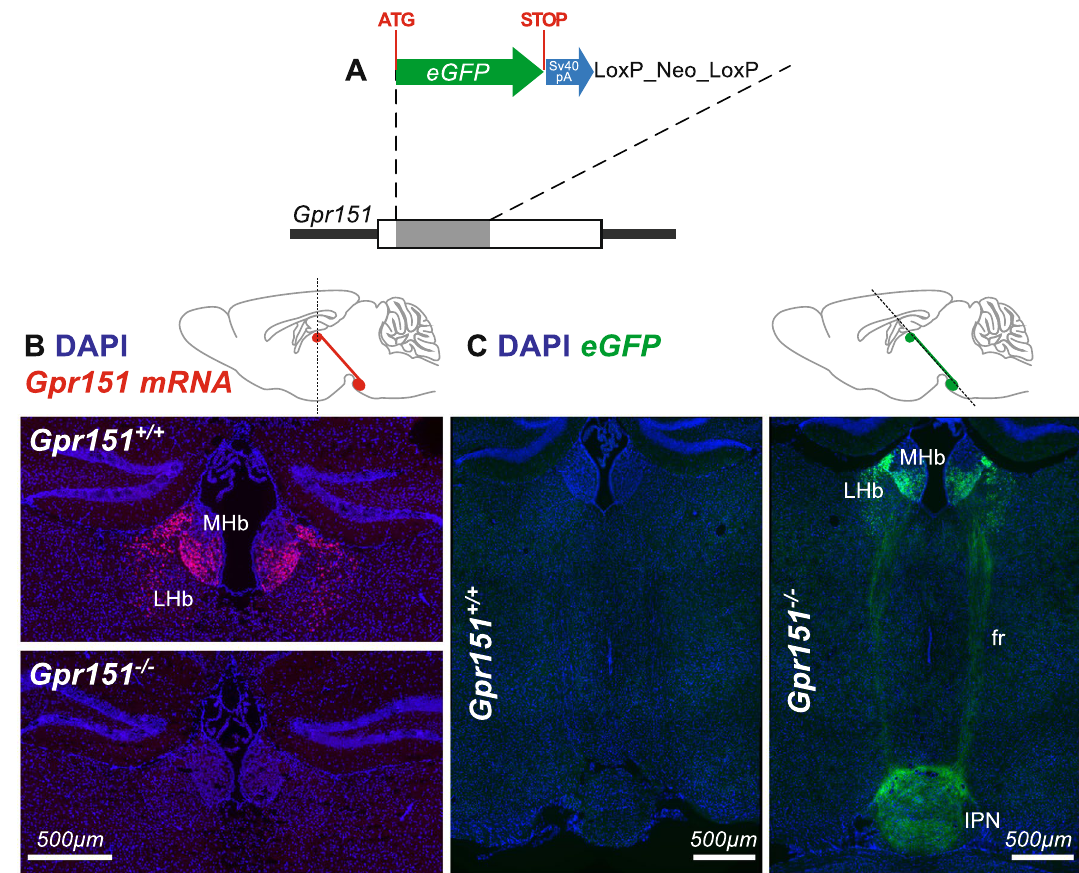
Figure 4. Generation and characterization of Gpr151 −/− knock-in mice. ( A ) Construction of the Gpr151 −/− knock-in mouse line. ( B ) Gpr151 mRNA in Gpr151 + / + and Gpr151 −/− brain slices using FISH. ( C ) eGFP